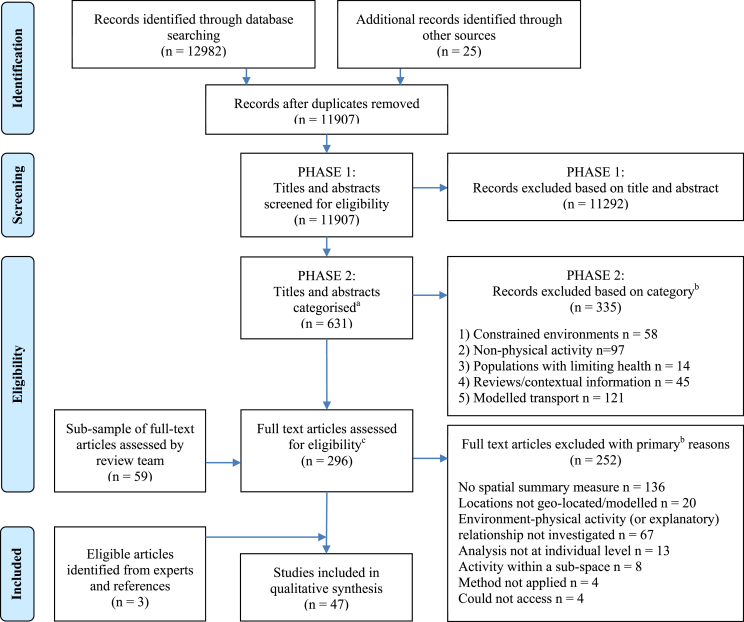
Study selection. aSee Table 2 for details on categories bSome studies met multiple criteria for exclusion. Categories and reasons for exclusion were ordered and only the criterion of highest order is shown cAll articles from category six (see Table 2).